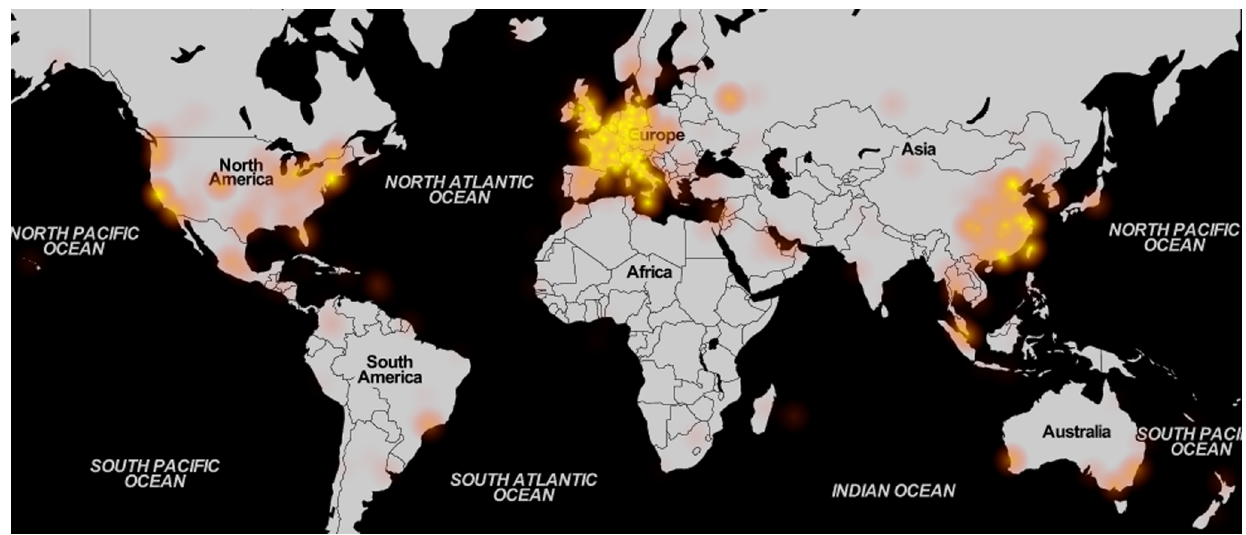
Figure 9. Perception heatmap. Worldwide sample density, including only measurements with attached perceptions, illustrated as a heatmap ( (cid:2) OpenStreetMap contributors for map data, used and redistributed under the CC-BY-SA licence[26]).